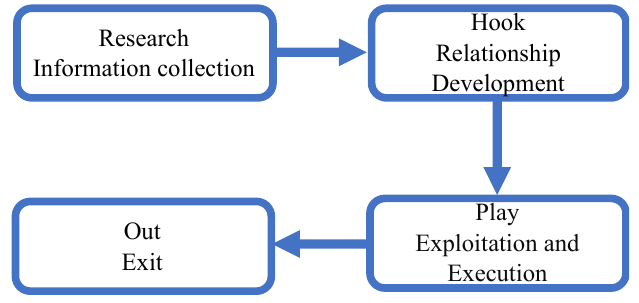
Figure 1. Social engineering attack stages [13].